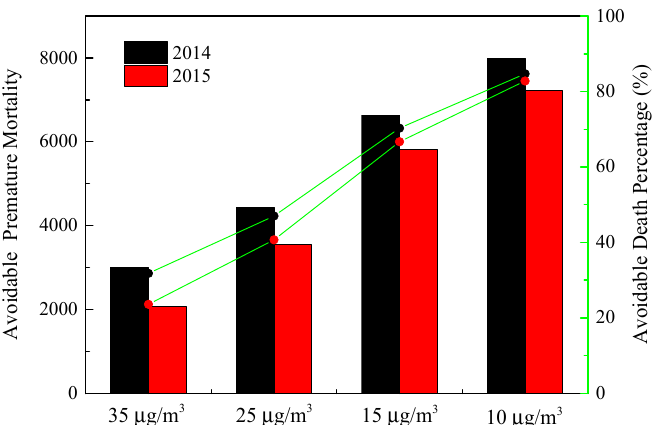
Figure 10. Potentially avoidable premature mortality and associated percentage from cutting down PM 2.5 concentrations to four standards.